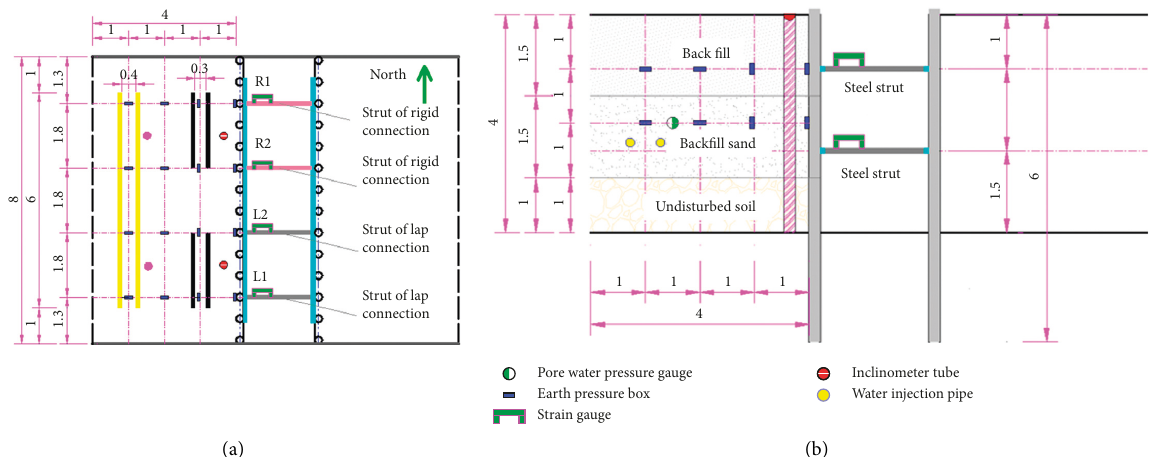
Figure 2: Layout of measuring points of foundation pit. (a) Vertical view. (b) Profile.